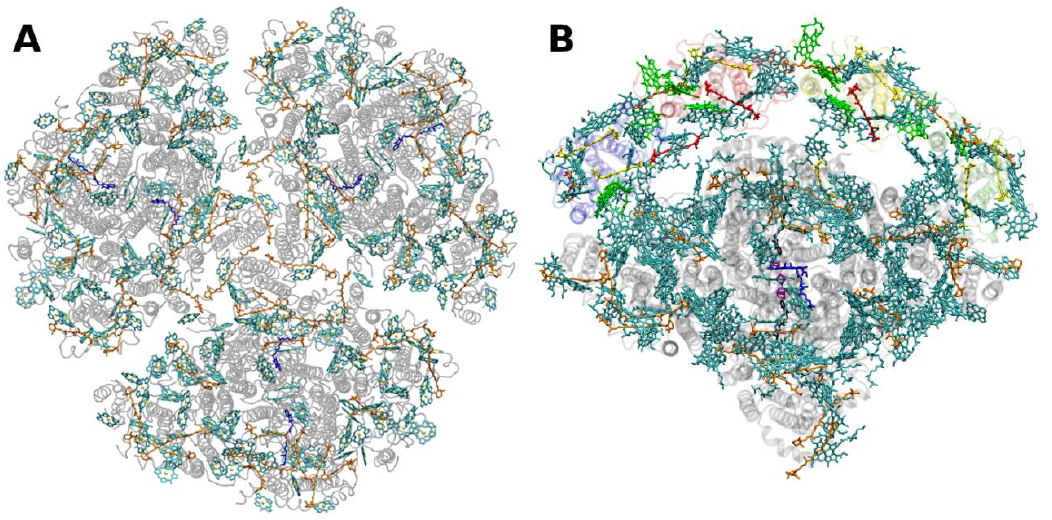
Figure 5. Structure of photosystem I. (A): from the thermophilic cyanobacterium Thermosynecchococcus elongatus at 2.5 Å resolution, PDB entry 1JB0 [61]. Top view with regard to the thylakoid membrane plane, seen from the stromal side. The protein backbone is shown in grey. Chlorophylls a are shown in cyan, β-carotenes in orange and phylloquinones in grey. (B): Structure of monomeric plant photosystem I from Pisum sativum with attached LHCI units (Lhca1–4, separated by color) at 2.6 Å resolution, PDB entry 5L8R [32]. Top view with regard to the thylakoid membrane plane, seen from the stromal side. Chlorophylls a and b are shown in cyan and green, respectively, β-carotenes in orange; the xanthophylls are color-coded as in Figure 1.